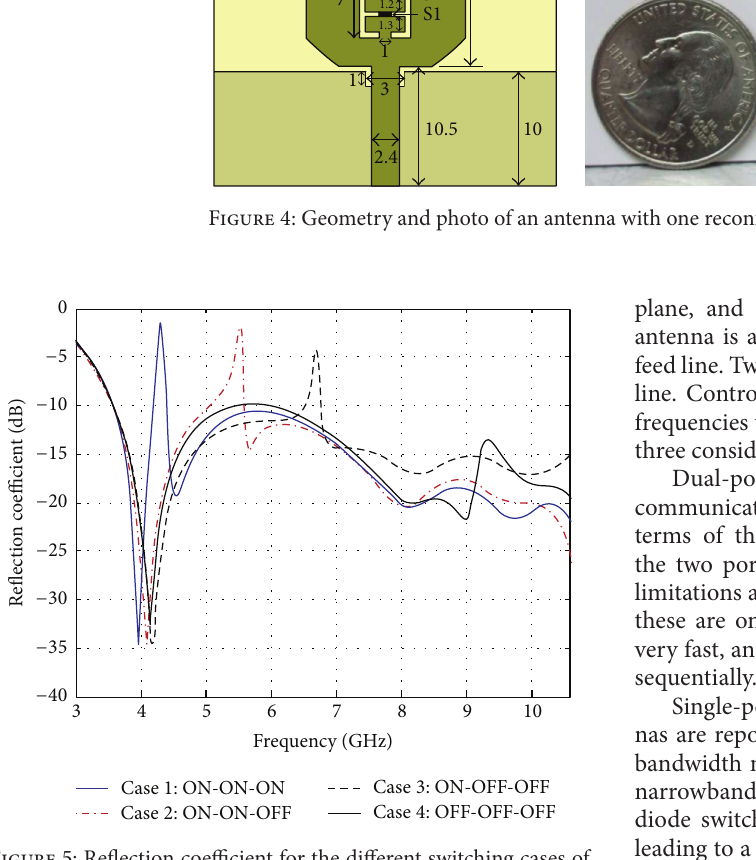
Figure 5: Reflection coefficient for the different switching cases of the antenna in Figure